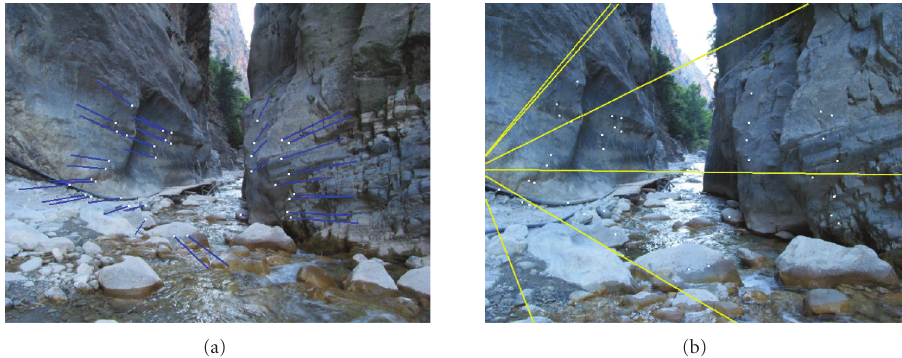
Figure 3: (a) Image I k along with computed optical flow vectors (blue segments) for all points marked white. (b) Image I k +1 along with matching points (also marked white) for all marked points of (a). A few epipolar lines are also shown. 10 scales S = { 1,0 . 9 − 1 , ... ,0 . 1 − 1 } have been used during matching.